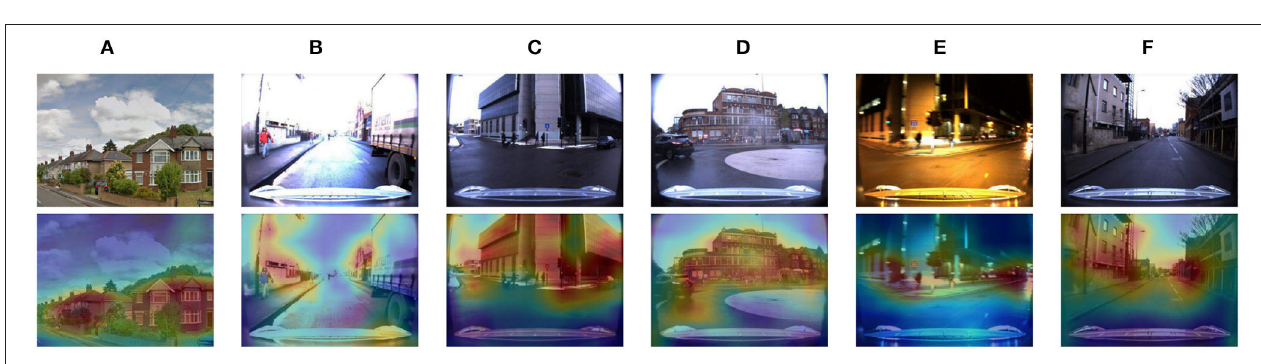
FIGURE 4 | Visualization of attention score maps on source domain (A) and target domains (B–F) unseen by the attention module at training